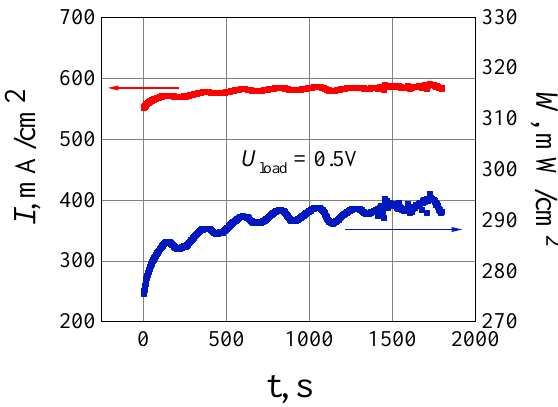
Figure 4. I (t) (red curve) and W (t) (blue curve) dependencies in the potentiostatic break-in mode ( U load = 0.5 V) for the MEA with pressing electrodes.